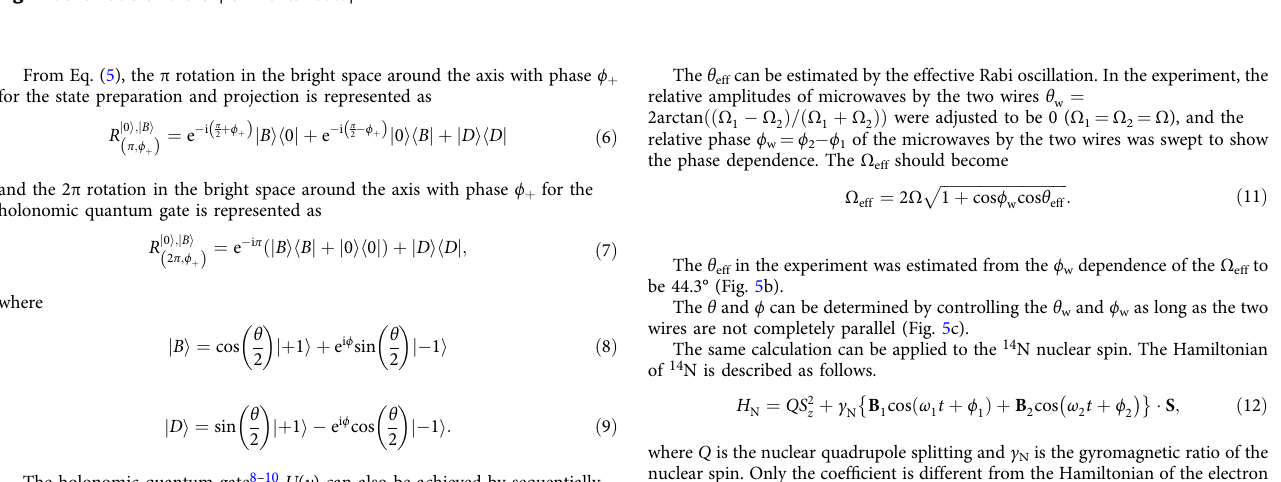
Fig. 7 Schematic of the experimental